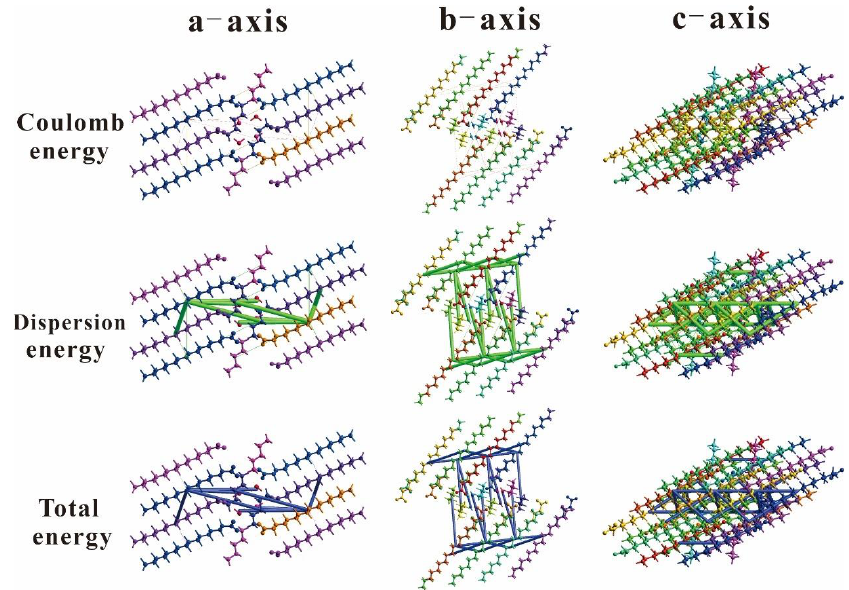
Figure 8. The diagrams of the interaction energies: Coulomb energy, dispersion energy, and total energy of 3C16 molecule along the a, b, and c axes.